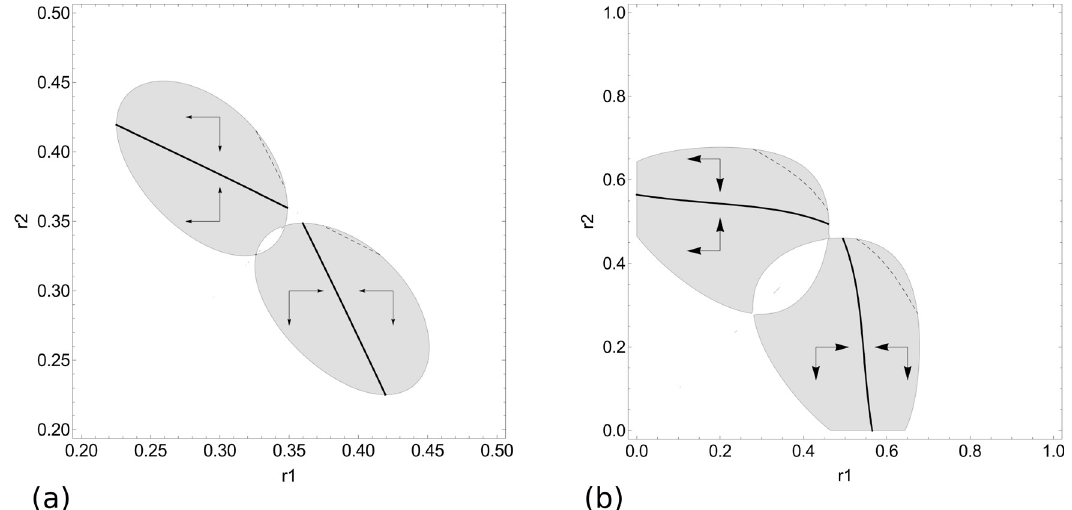
Fig 6. Areas of coexistence and evolutionary isoclines. The grey areas are where there is possible coexistence between strategy r 1 and r 2 . The solid lines represent stable isoclines (fitness maxima), whereas the dashed lines represent unstable isoclines (fitness minima). Arrows indicate the direction of evolution. a) a situation where competition asymmetry is low ( ϕ = 1) and food item density is intermediate ( ρ = 0.488); b) a situation where competition asymmetry is high ( ϕ = 5) and food item density is high ( ρ = 0.986). Here, b = 0.1 and μ = 0.001.